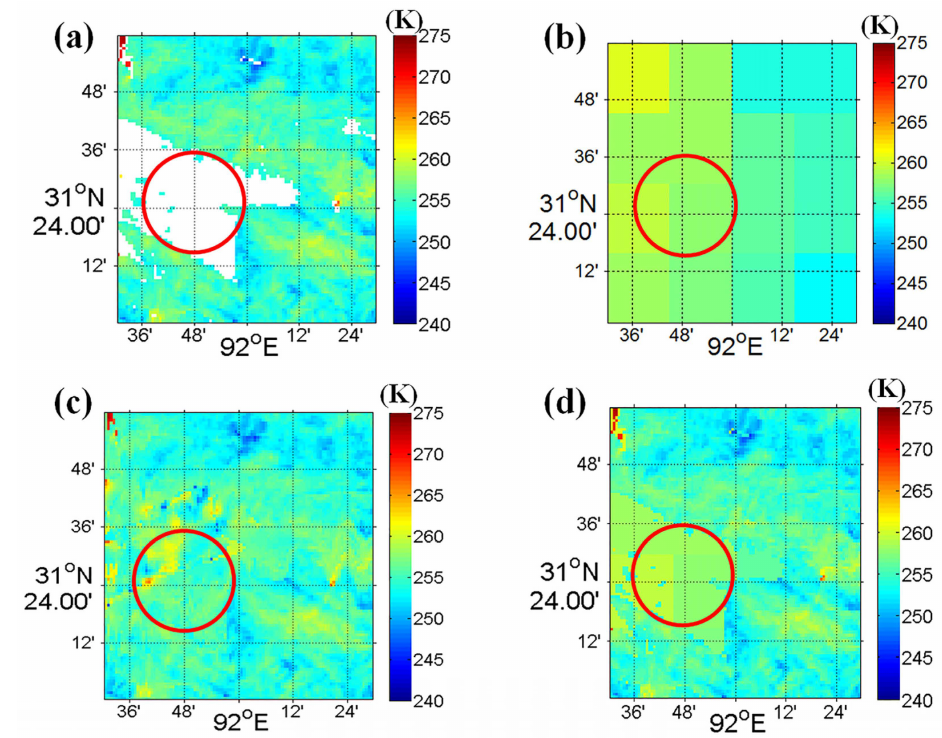
Figure 10. Comparison of the LSTs (in Kelvin): ( a ) MODIS LST; ( b ) AMSR-E LST; ( c ) merged LST by the BME method; and ( d ) mixed LST by the gap filling method on 17 November